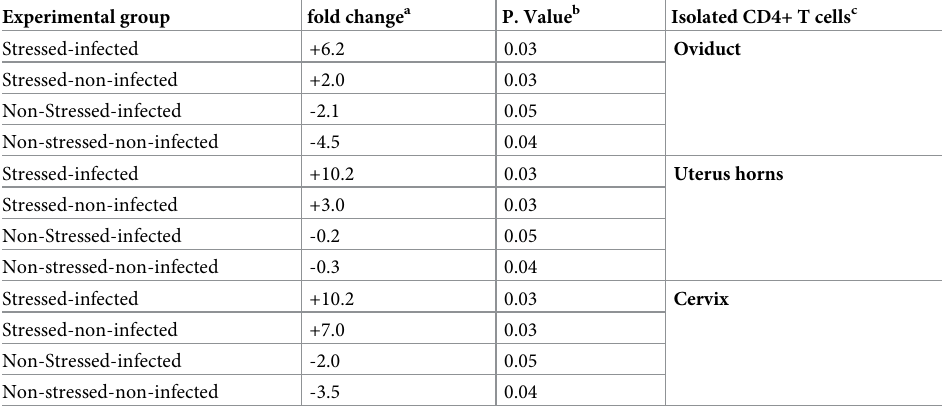
Table 1. Fold-changes of gene expression of GATA-3 in lysates of the whole or parts of the genital tract of stressed or non-stressed mice during C . muridarum genital infection. Data shown are representative of two or more inde- pendent experiments performed on different dates. Experimental group fold change a P. Value b Isolated CD4+ T cells c Stressed-infected +6.2 0.03 Oviduct Stressed-non-infected +2.0 0.03 Non-Stressed-infected -2.1 0.05 Non-stressed-non-infected -4.5 0.04 Stressed-infected +10.2 0.03 Uterus horns Stressed-non-infected +3.0 0.03 Non-Stressed-infected -0.2 0.05 Non-stressed-non-infected -0.3 0.04 Stressed-infected +10.2 0.03 Cervix Stressed-non-infected +7.0 0.03 Non-Stressed-infected -2.0 0.05 Non-stressed-non-infected -3.5 0.04